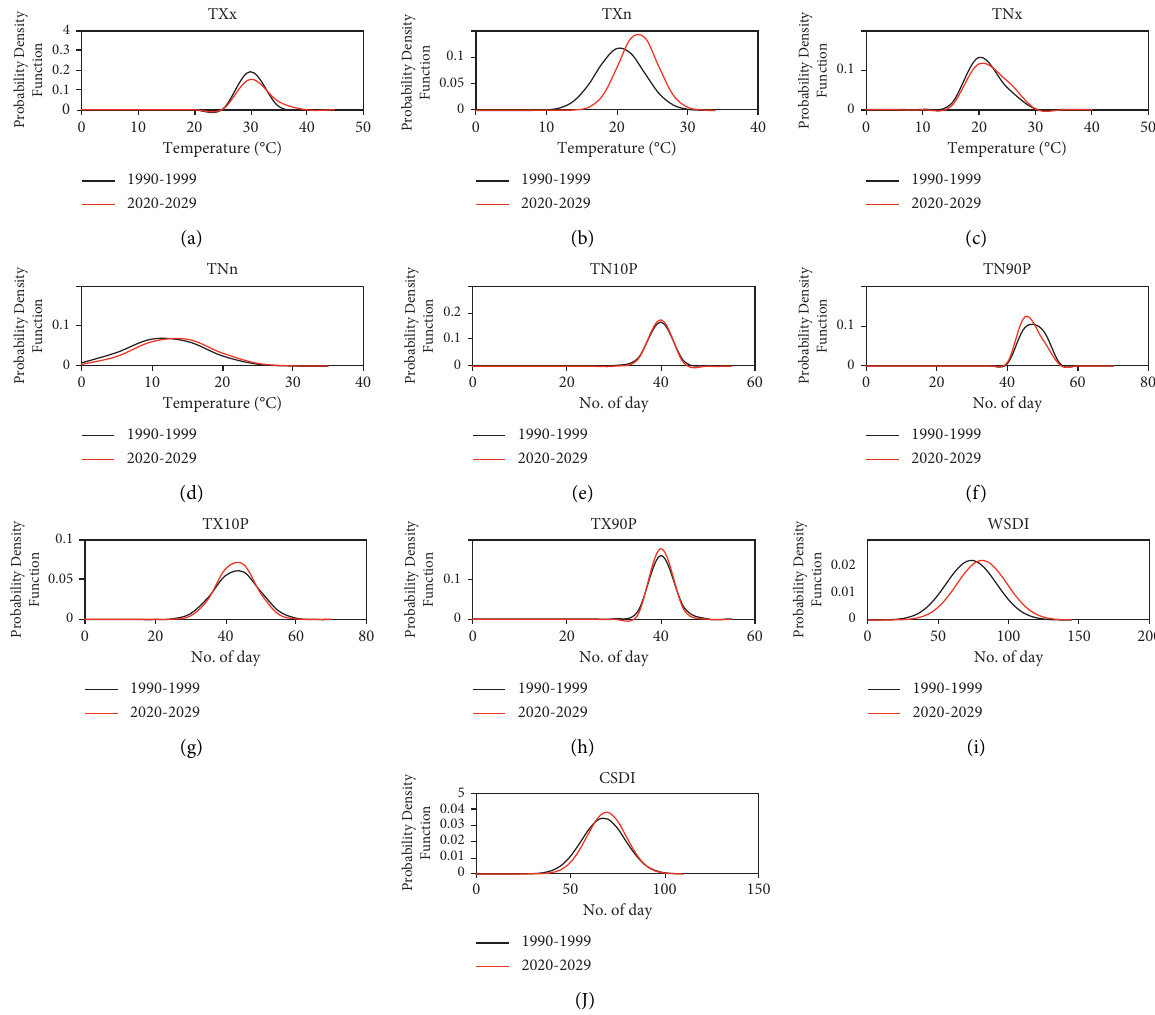
Figure 4: Probability distribution function of the (a) TXx, (b) TXn, (c) TNx, (d) TNn, (e) TN10P, (f) TN90P, (g) TX10P, (h) TX90P, (i) WSDI, and (J) CSDI between the years 2020–2029 and 1990–1999 in northern Thailand.